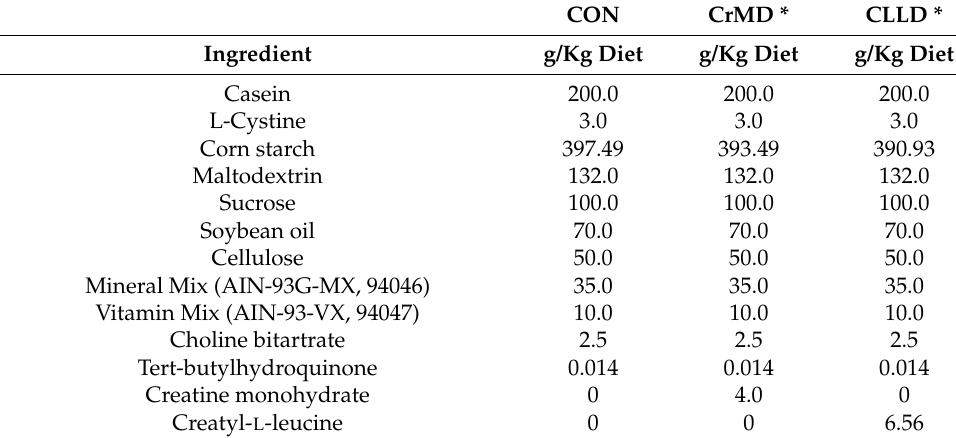
Table 1. Composition of experimental